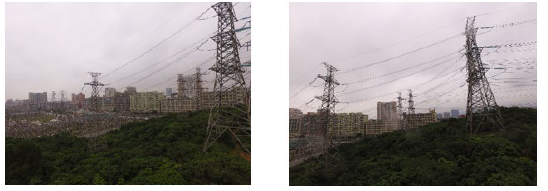
Figure 5. Transmission lines taken by drone